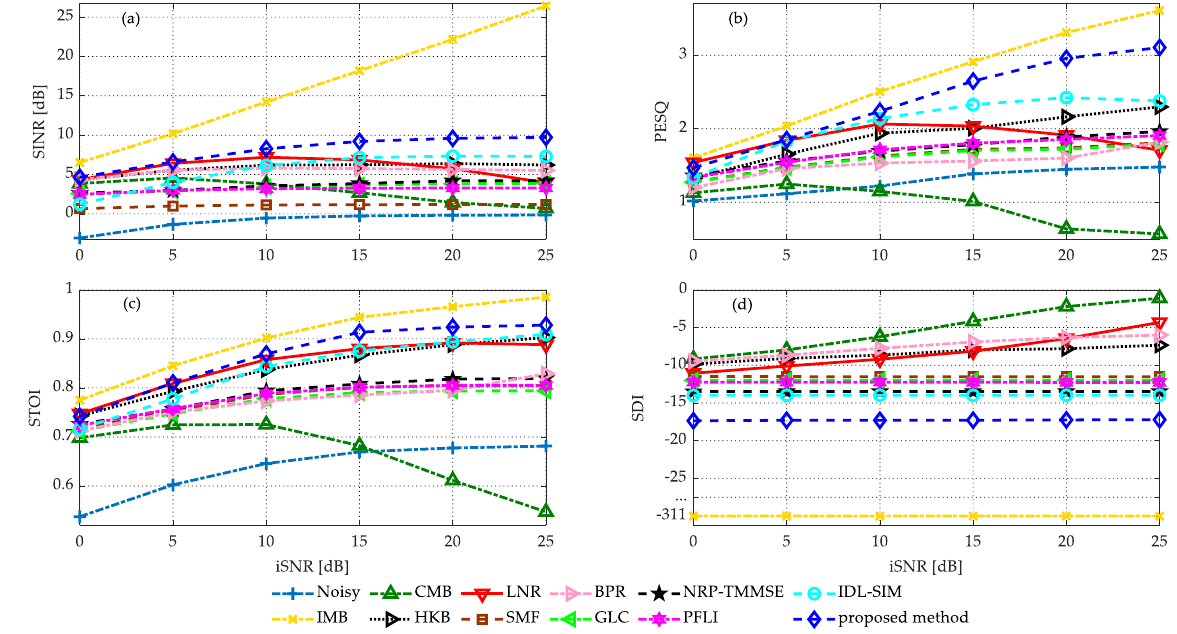
Figure 4. The results of the evaluation measures under different iSNRs: ( a ) SINR; ( b ) PESQ; ( c ) STOI; ( d ) SDI.